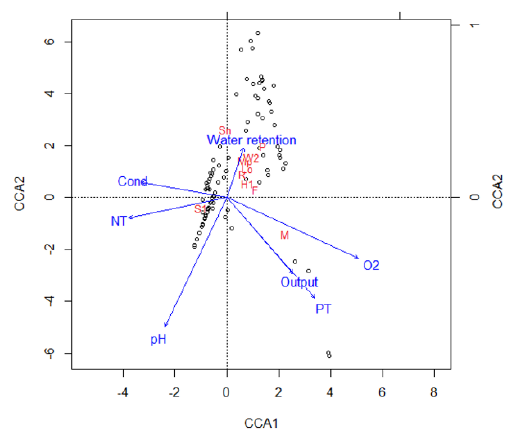
Figure 6. Canonical Correspondence Analysis (CCA) ap- plied to abiotic (Cond.= condutivity; TN= total nitrogen; pH= hydrogen potential; TP= total phosphorus, Output; O2= dissolved oxygen; Water retention=residence time and functional groups ( S1, M, H1, Lo, P, F, S MP e R ) at Armando Ribeiro Gonçalves Reservoir from April 2009 to October 2011.